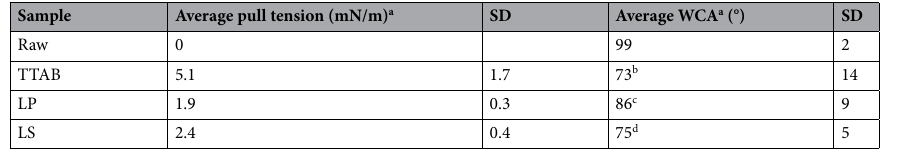
Table 4. Wettability of the fibers treated with different softeners expressed as relative pull tension and water contact angle (WCA). a Average values over the full data set coming from the same softener used (irrespective of concentration, temperature and time). b Significantly different with respect to the raw fiber at the 0.01 level (one-way ANOVA test). c Significantly different with respect to the raw fiber at the 0.5 level (one-way ANOVA